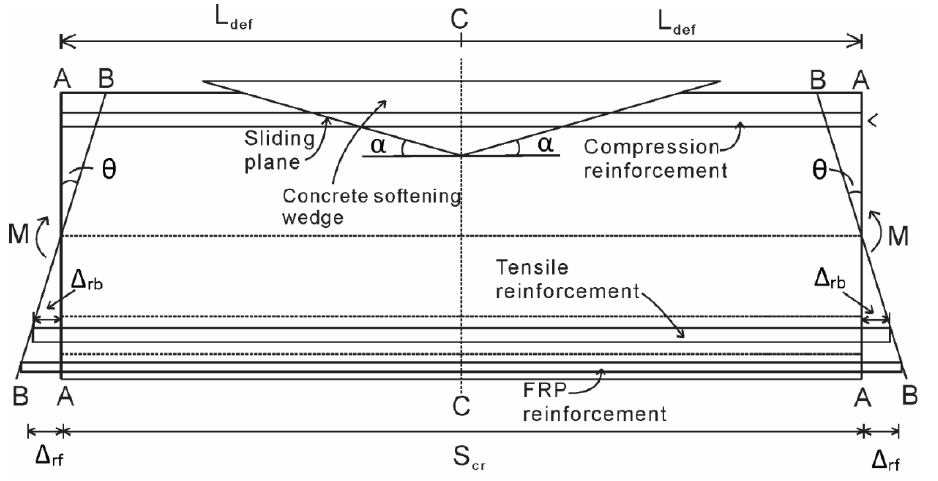
Figure 1. Beam segment of NSM FRP strengthened RC